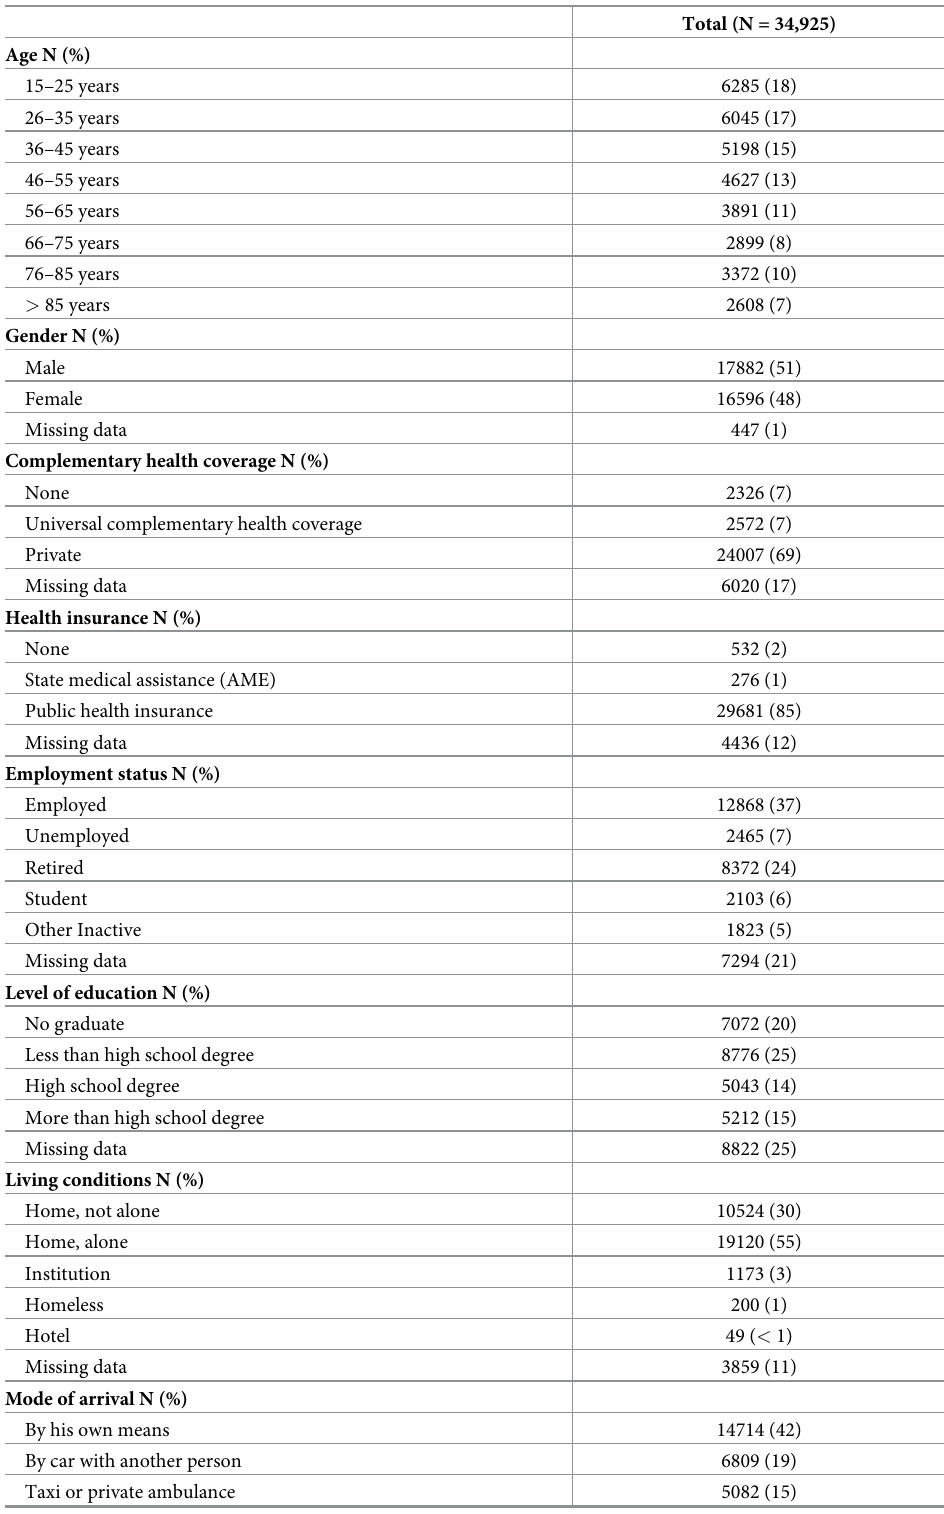
Table 4. Characteristics of users older than 15